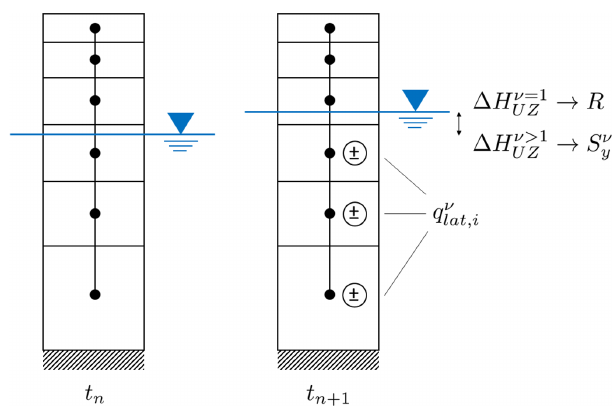
Figure 2. Illustrative example of the time step integration for one 1D model in the iteratively coupled